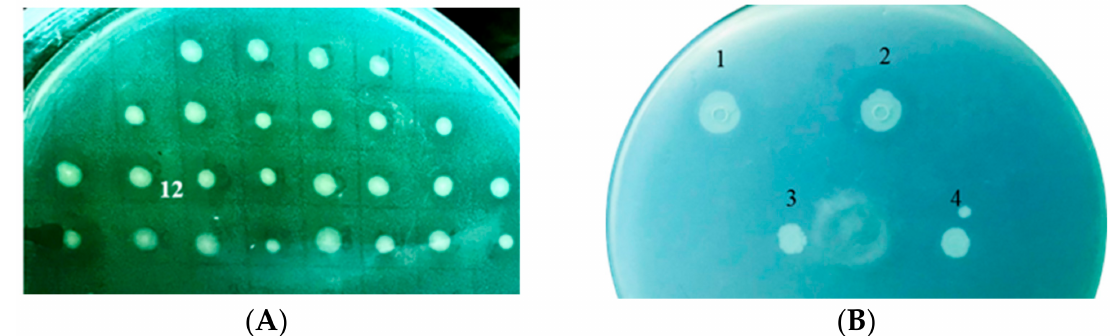
Figure 2. Bacteriocin assay of the gene knockout strains. ( A ) Bacteriocin activity of the gene selection strain (89-H-rif-12). ( B ) Comparison of bacteriocin activity of wild types and dgc defective mutants: 1, Pcc 3F3; 2, 89-H-rif-89-12; 3, 89-H-rif-12/ ∆ dgc-Tet; 4, 89-H-rif-12/ ∆ dgc-Kan. The pG-dgc-Kan and pG-dgc-Tet constructs are utilized for double confirmation